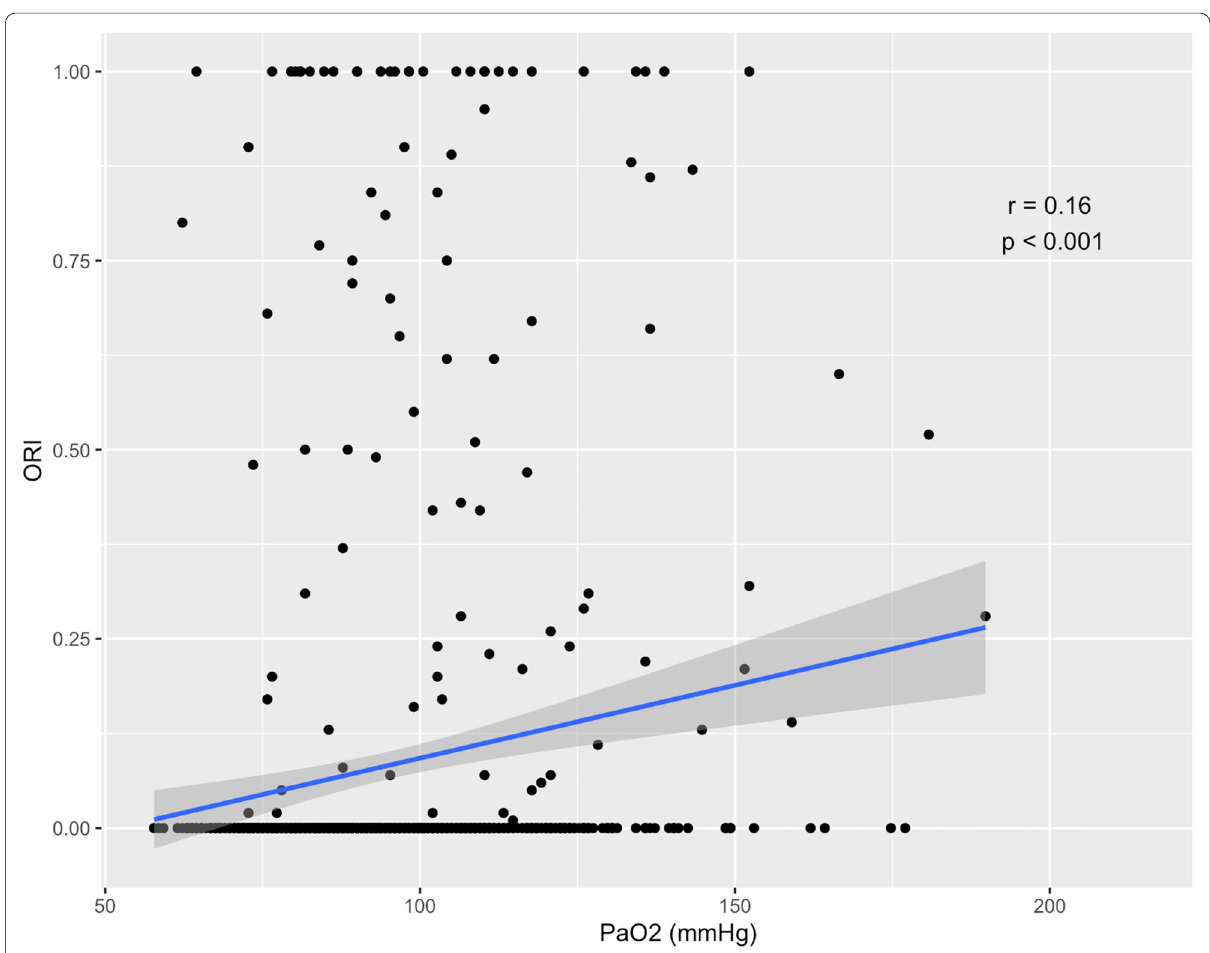
Fig. 2 Global correlation between oxygen partial pressure (PaO 2 ) and Oxygen Reserve Index